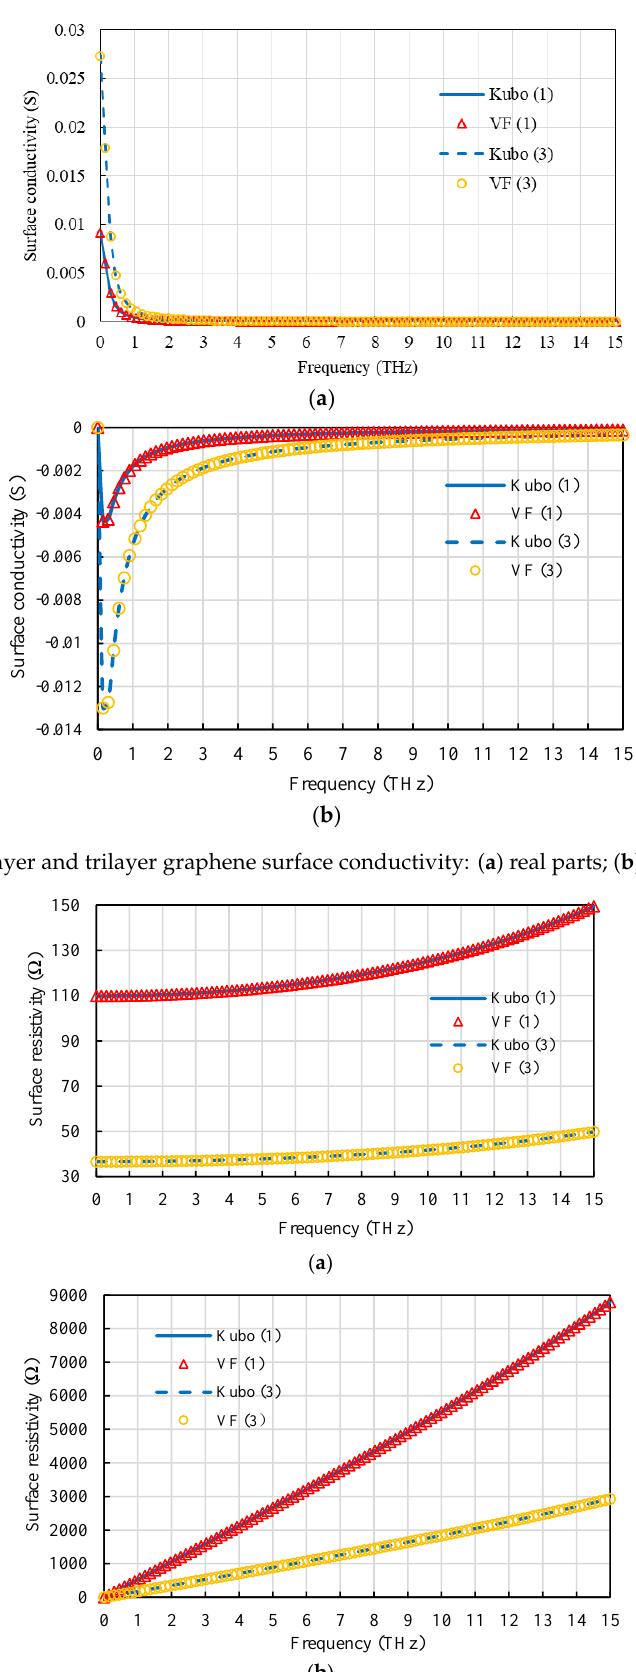
Table 2. a v and dv of trilayer graphene surface resistivity.